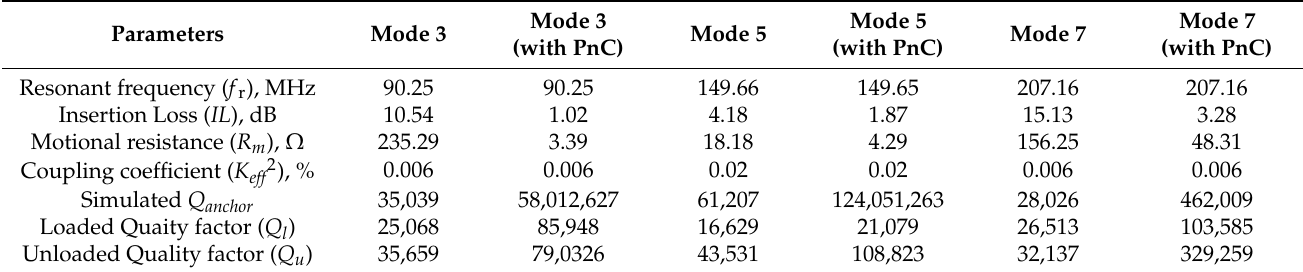
Table 4. Comparison of performance parameters of four MEMS